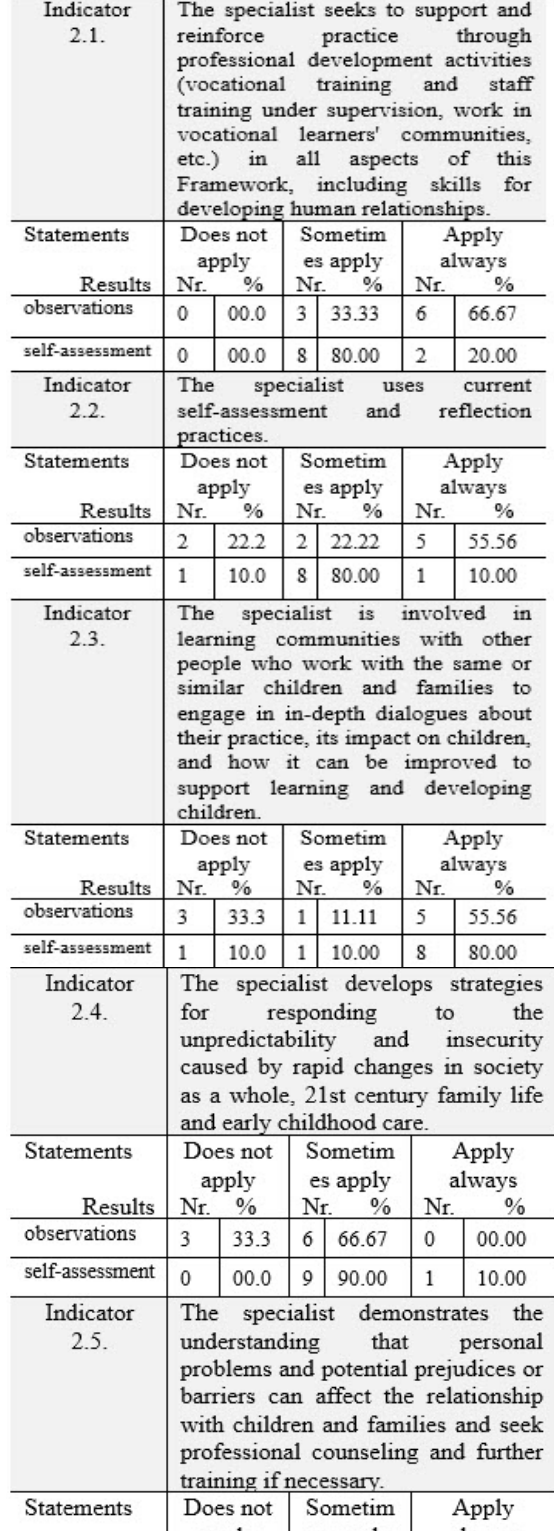
Table 32. Principle 2: Continuous par - ticipation in professional development activi - ties improves the quality of practice.